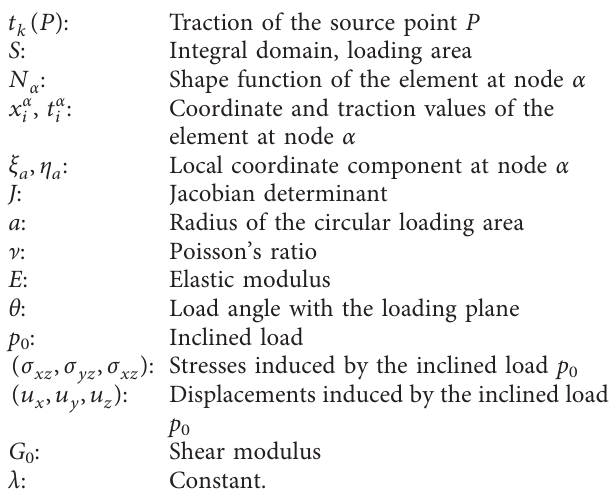
xx / p ; (b) σ yy / p ; (c) σ zz / p ; (d) σ xz / p